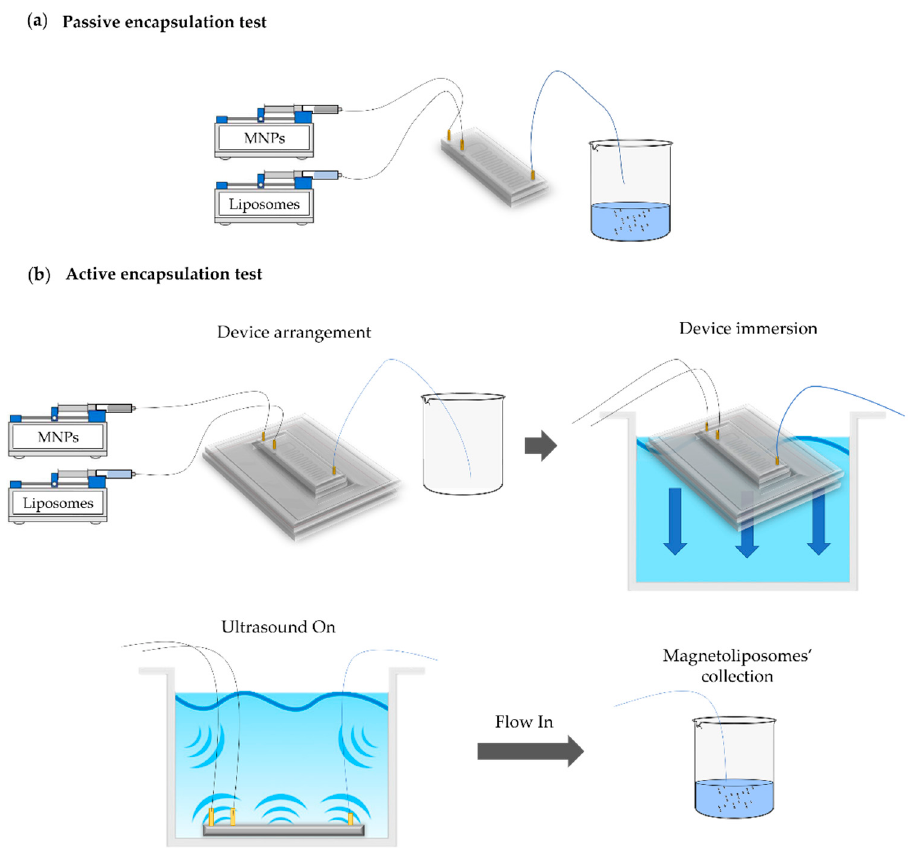
Figure 3. Schematic representation of the encapsulation tests and the assembly of involved compo- nents. ( a ) Passive encapsulation; ( b ) Active encapsulation. For both active and passive encapsulation, syringes loaded with liposomes and the nanoconjugates were first introduced into syringe pumps. For each pump, the flow rate was adjusted according to the intended FRR. Additionally, the microfluidic device with the mounting base was immersed into the ultrasonic bath for the active encapsulation test. Finally, to begin both experiments, the syringe pumps were turned on. After letting fluid flow for 320 s, 5 mL of MLPs was collected in a beaker for each experiment until the syringes were completely emptied.